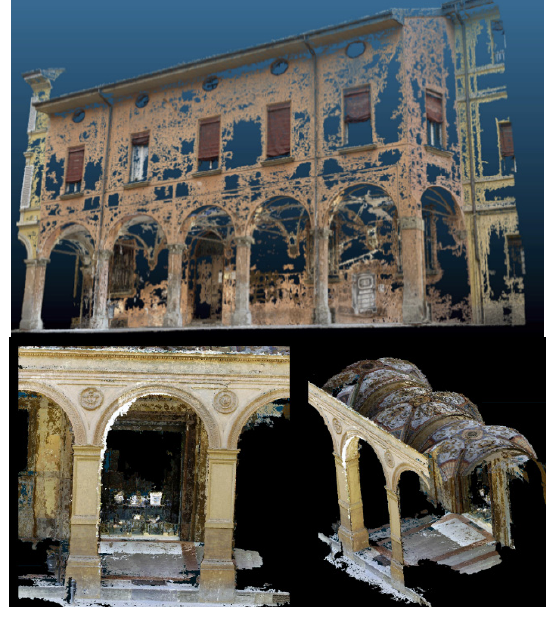
Figure 3. Cont. Figure 3.